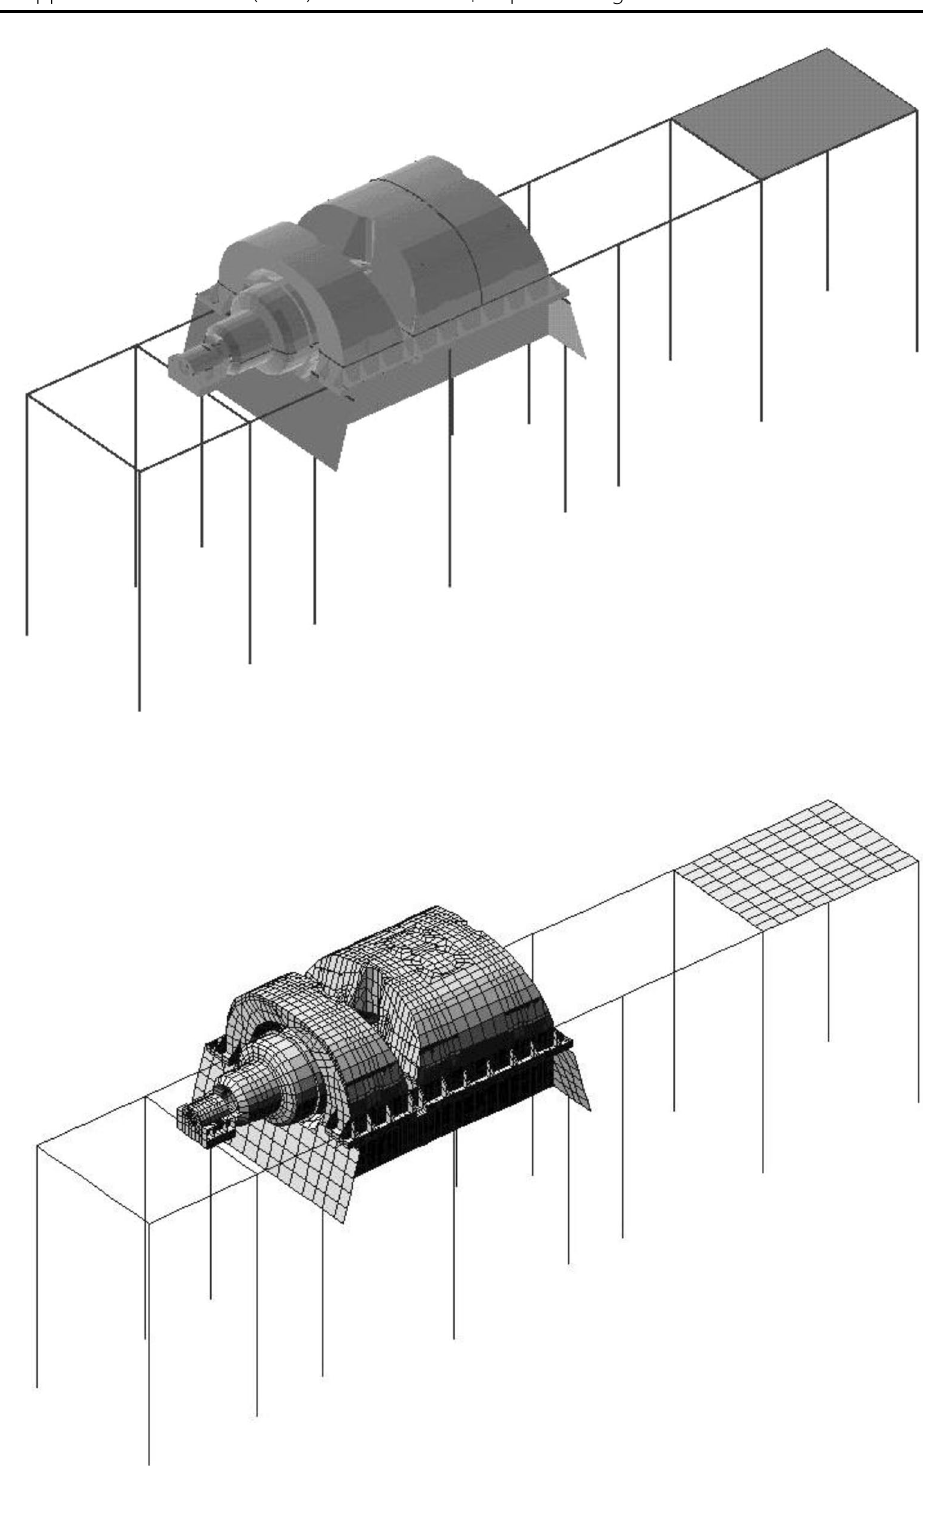
Fig. 2 Geometric basic model